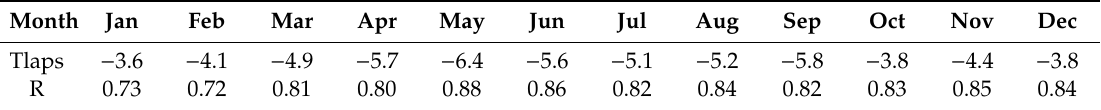
Table 2. Monthly temperature laps rate (Tlaps) ( ◦ C / km) and correlation coe ffi cient (R) between temperature and